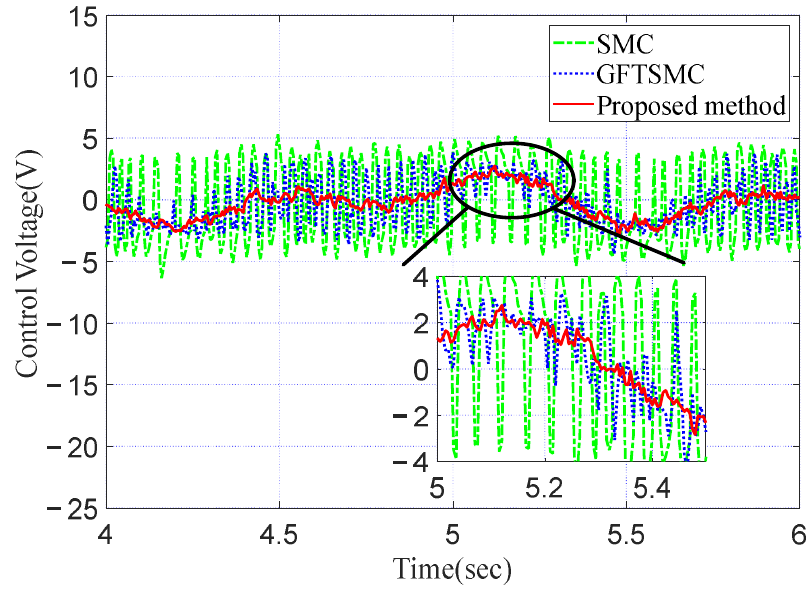
Figure 4. The control voltages of different control methods.